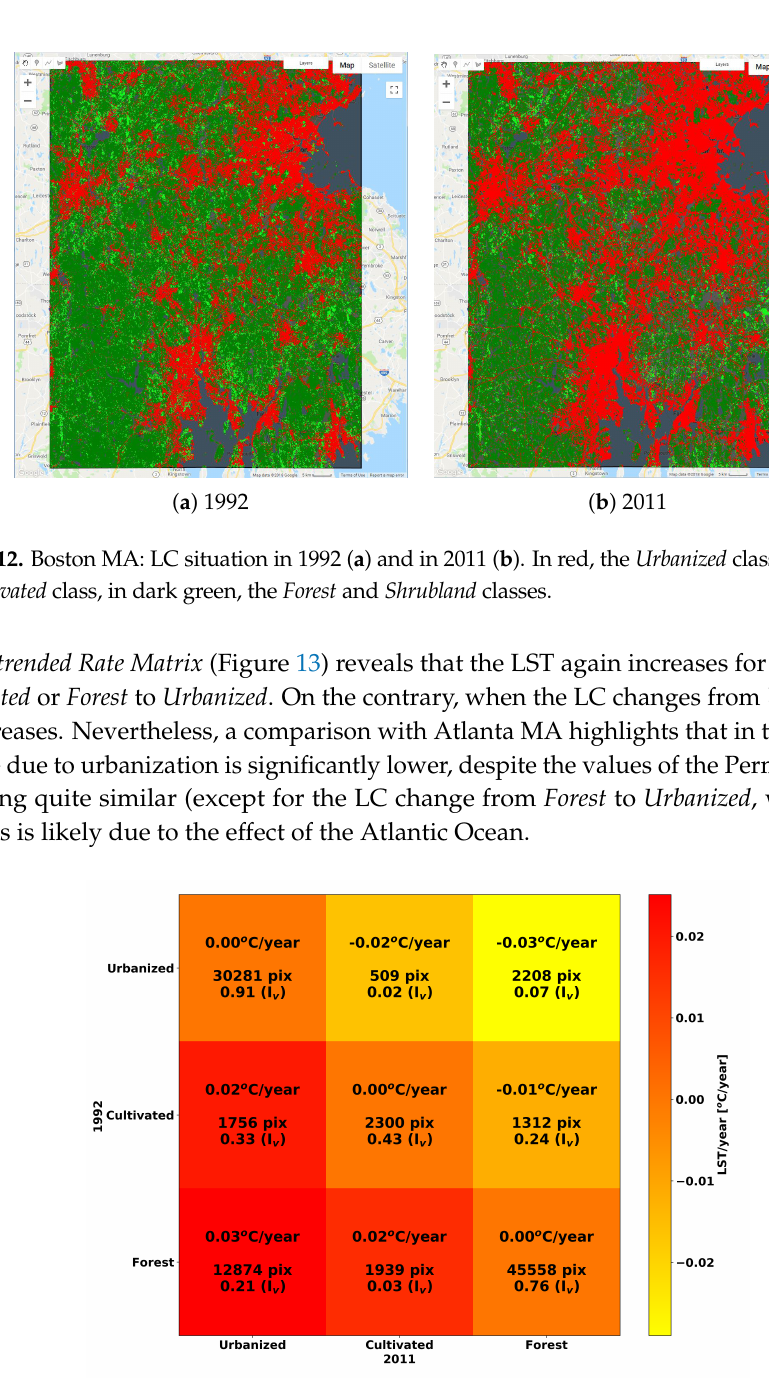
Figure 13. Boston MA: Detrended Rate